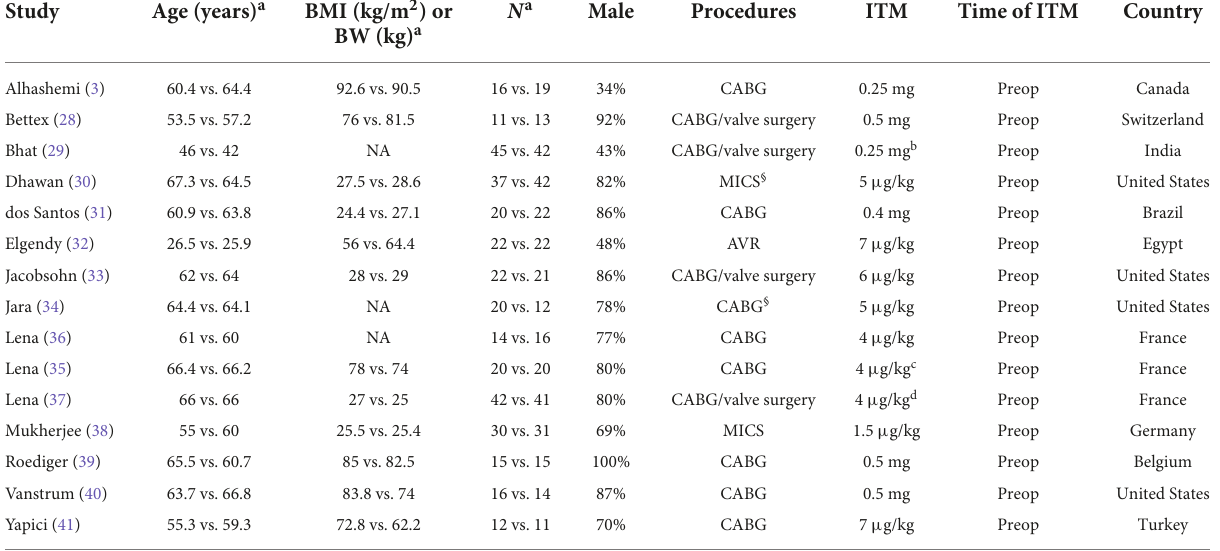
AVR,aorticvalvereplacement;MICS,minimallyinvasivecardiacsurgery;ITM,intrathecalmorphine; a presentasITMvs.controlgroup; b combinedwith40mgMarcaine; c combinedwith clonidine 1 µ g/kg; d combined with clonidine 2 µ g/kg; Preop, pre-operation; BW, body weight; BMI, body mass index; Coronary artery bypass graft surgery (CABG); § cardiopulmonary